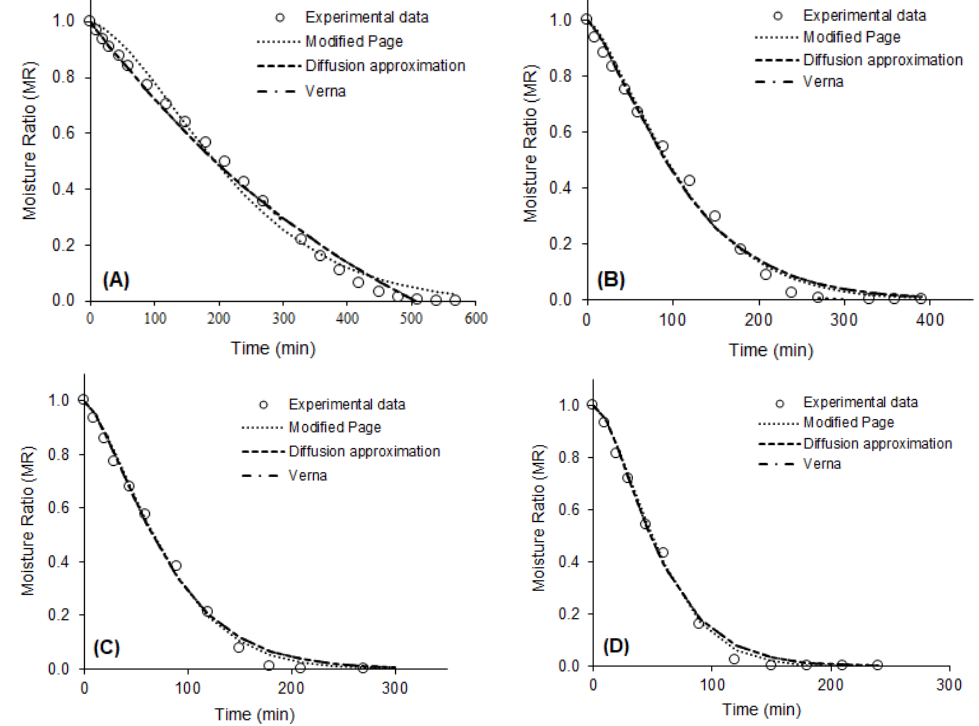
Figure 2. Experimental drying data and drying curves predicted by the modified Page, Diffusion Approximation, and Verna models. ( A ) 40 °C; ( B ) 50 °C; ( C ) 60 °C; ( D ) 70 °C. Table 2. Statistics modeling and parameters of the mathematical models adjusted to the drying data of the purple basil leaves.